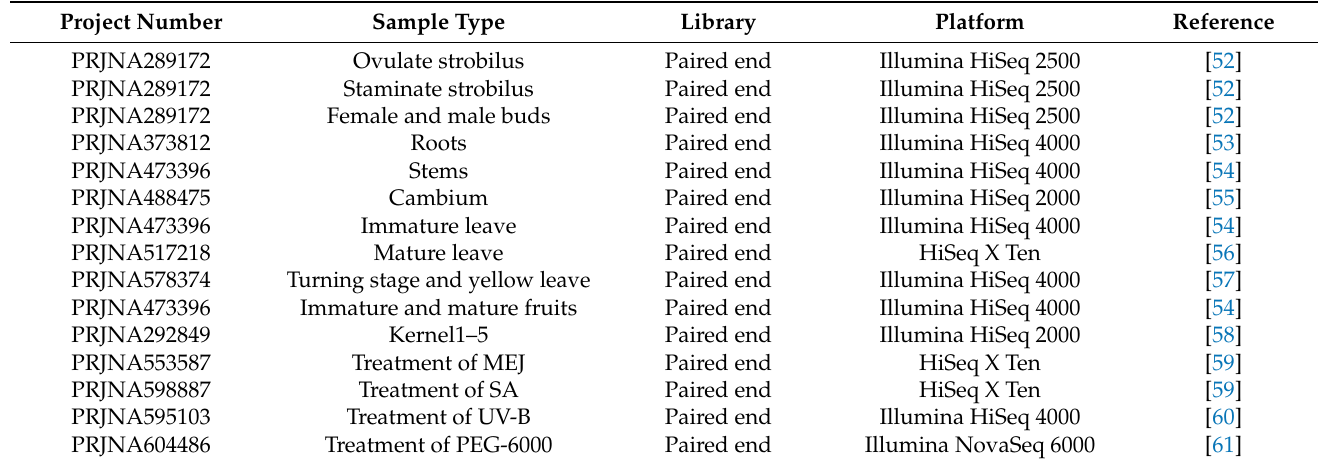
Table 3. List of RNA-Seq data in GBARF family of